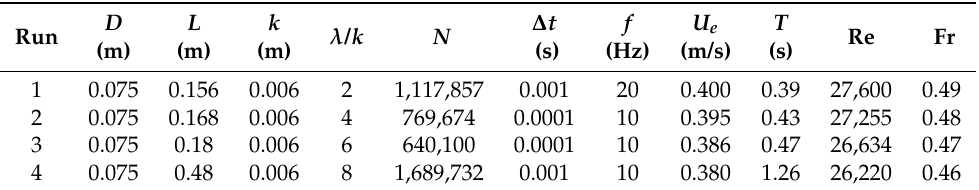
Figure 1. Transverse square bars placed at the model channel bed as roughness elements (elevation view): ( a ) definition diagram of model channel parameters, including the longitudinal spacing λ of roughness elements and roughness height k ; ( b ) model channel for the case λ / k = 2. k serves as the macro-scale roughness of the channel-bed. For clarity, only part of the model channel and roughness elements are shown. The channel dimension in the transverse direction (or the x 3 -direction) is 0.075 m. Table 1. Model channel dimensions, roughness characteristics, mesh, and hydraulic conditions for LES